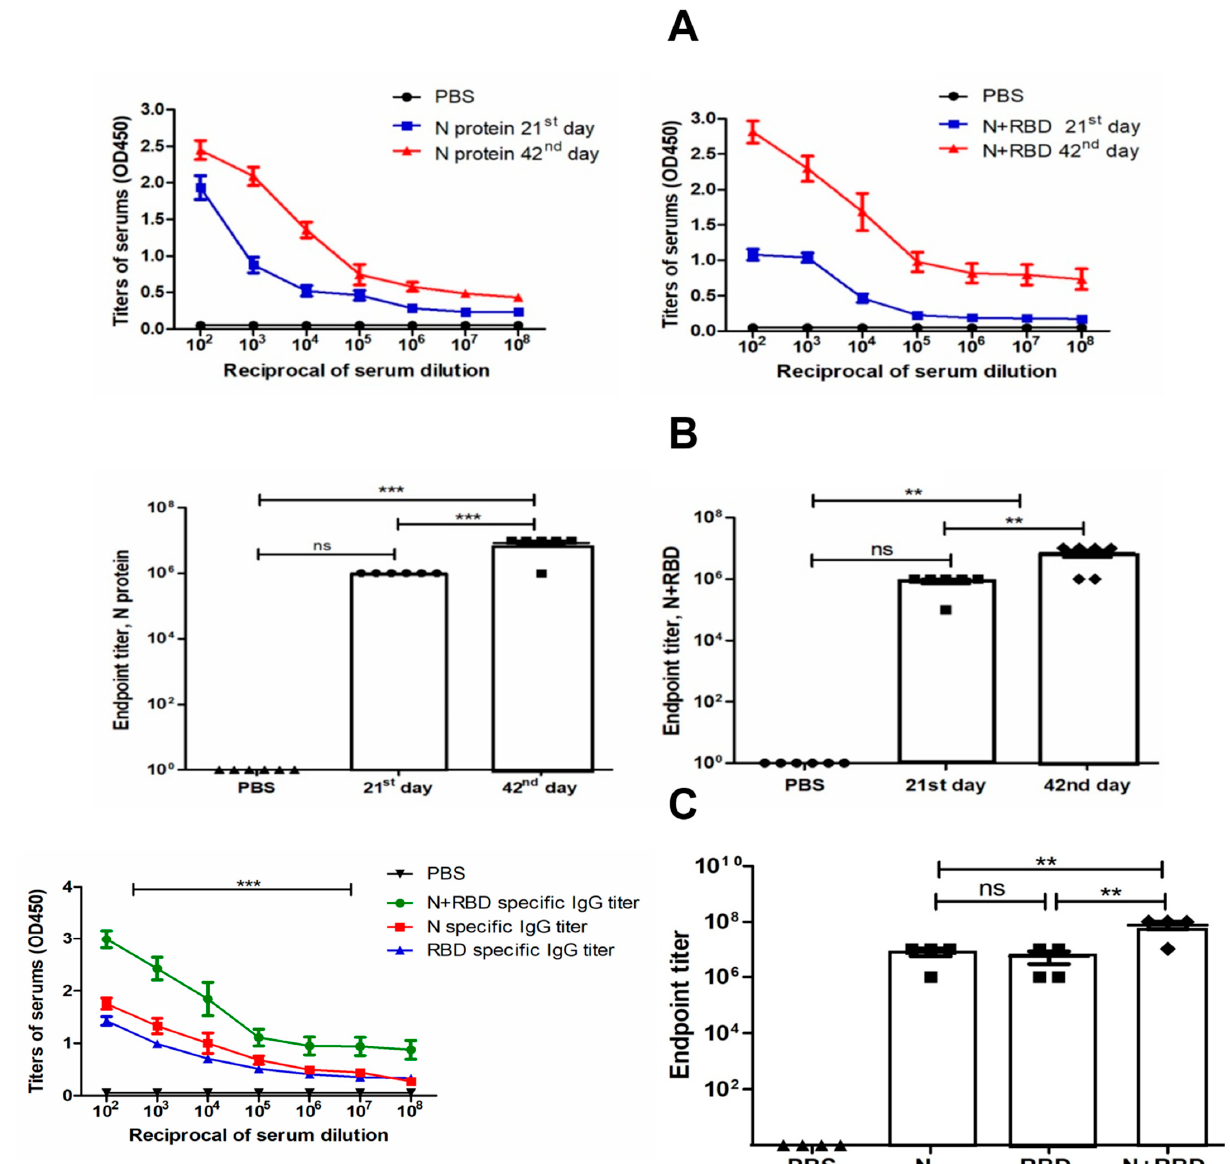
Figure 5. Immunogenicity of plant-produced N protein and N+RBD in mice. First, 6–7 week old Balb/c male mice were immunized on IM with 5 μ g of plant-produced N and N+RBD using Alhydrogel as an adjuvant on the 0th and 21st days. IgG titers of mice immunized with plant-produced N and N+RBD antigens were determined by ELISA from sera collected on the 21st and 42nd days after injection. For the detection of IgG titers, mouse sera on the 21st day and 42nd days were evaluated by 10 2 to 10 8 serum dilutions. ( A ) Detection of specific IgG titers in 21st and 42nd day sera from mice immunized with N and N+RBD. ( B ) Detection of endpoint titers in sera with different dilutions specific to N and N+RBD on days 21 and 42. ( C ) Determination of specific IgG titer for N, RBD, and N+RBD antigens in mice immunized with plant-produced N+RBD. First, 6–7 week old Balb/c male mice were immunized on IM with 5 μ g of plant-produced RBD [4] and N+RBD using Alhydrogel as an adjuvant on the 0th and 21st days. Specific IgG titers of mice immunized with plant-produced N+RBD were determined by ELISA from sera collected on the 42nd day after injection. The ELISA plate was coated with 100 ng of plant-produced N, RBD [4], and N+RBD proteins. ( C ) (left) N-, RBD- [4], and N+RBD-specific IgG titers on 42nd day sera from mice immunized with N+RBD. ( C ) (right) Detection of endpoint titers in mice sera immunized with N+RBD with different dilutions specific to N, RBD, and N+RBD on day 42. Endpoint titer was derived from reciprocal dilutions of sera, giving an OD value four times greater than mouse sera receiving PBS with Alhydrogel as a control sample. Data in the graph are shown as the mean ± standard error of the mean (SEM) of triplicates at each sample dilution. Statistical analysis was performed using Tukey’s multiple comparison tests; ** p < 0.01, and *** p < 0.001 ( n = 6